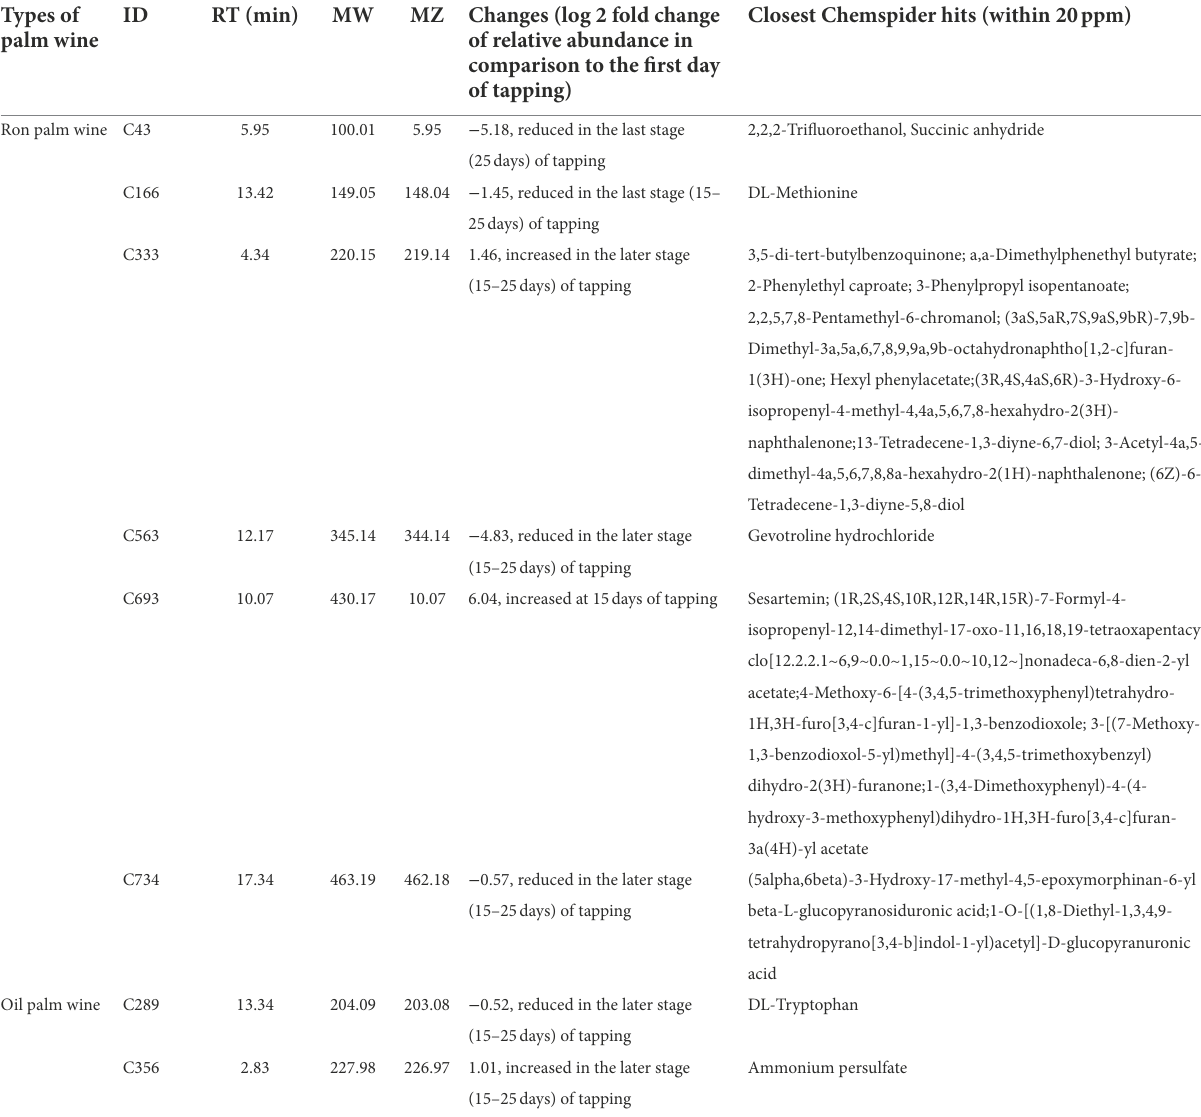
TABLE 1 Identities of the significantly differing metabolites over different stages of ron palm wine and oil palm wine tapping, by LC-HRMS analysis. Types of palm wine